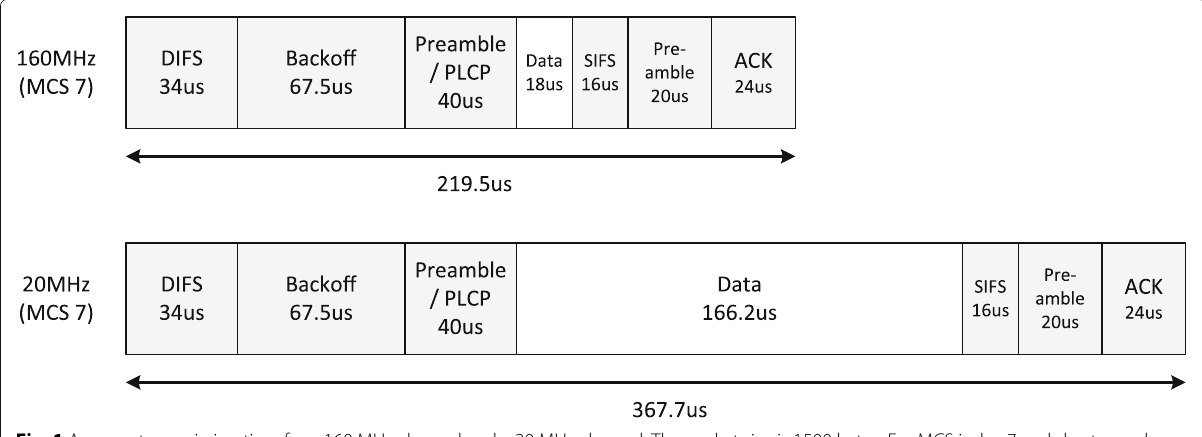
Fig. 1 Average transmission time for a 160 MHz channel and a 20 MHz channel. The packet size is 1500 bytes. For MCS index 7 and short guard interval, the data rate for 20 MHz is 72.2 Mbps, while the data rate for 160 MHz is 650 Mbps. Although the data rate of a 160 MHz channel is nine times the data rate of a 20 MHz channel, the time for transmitting a packet is not significantly